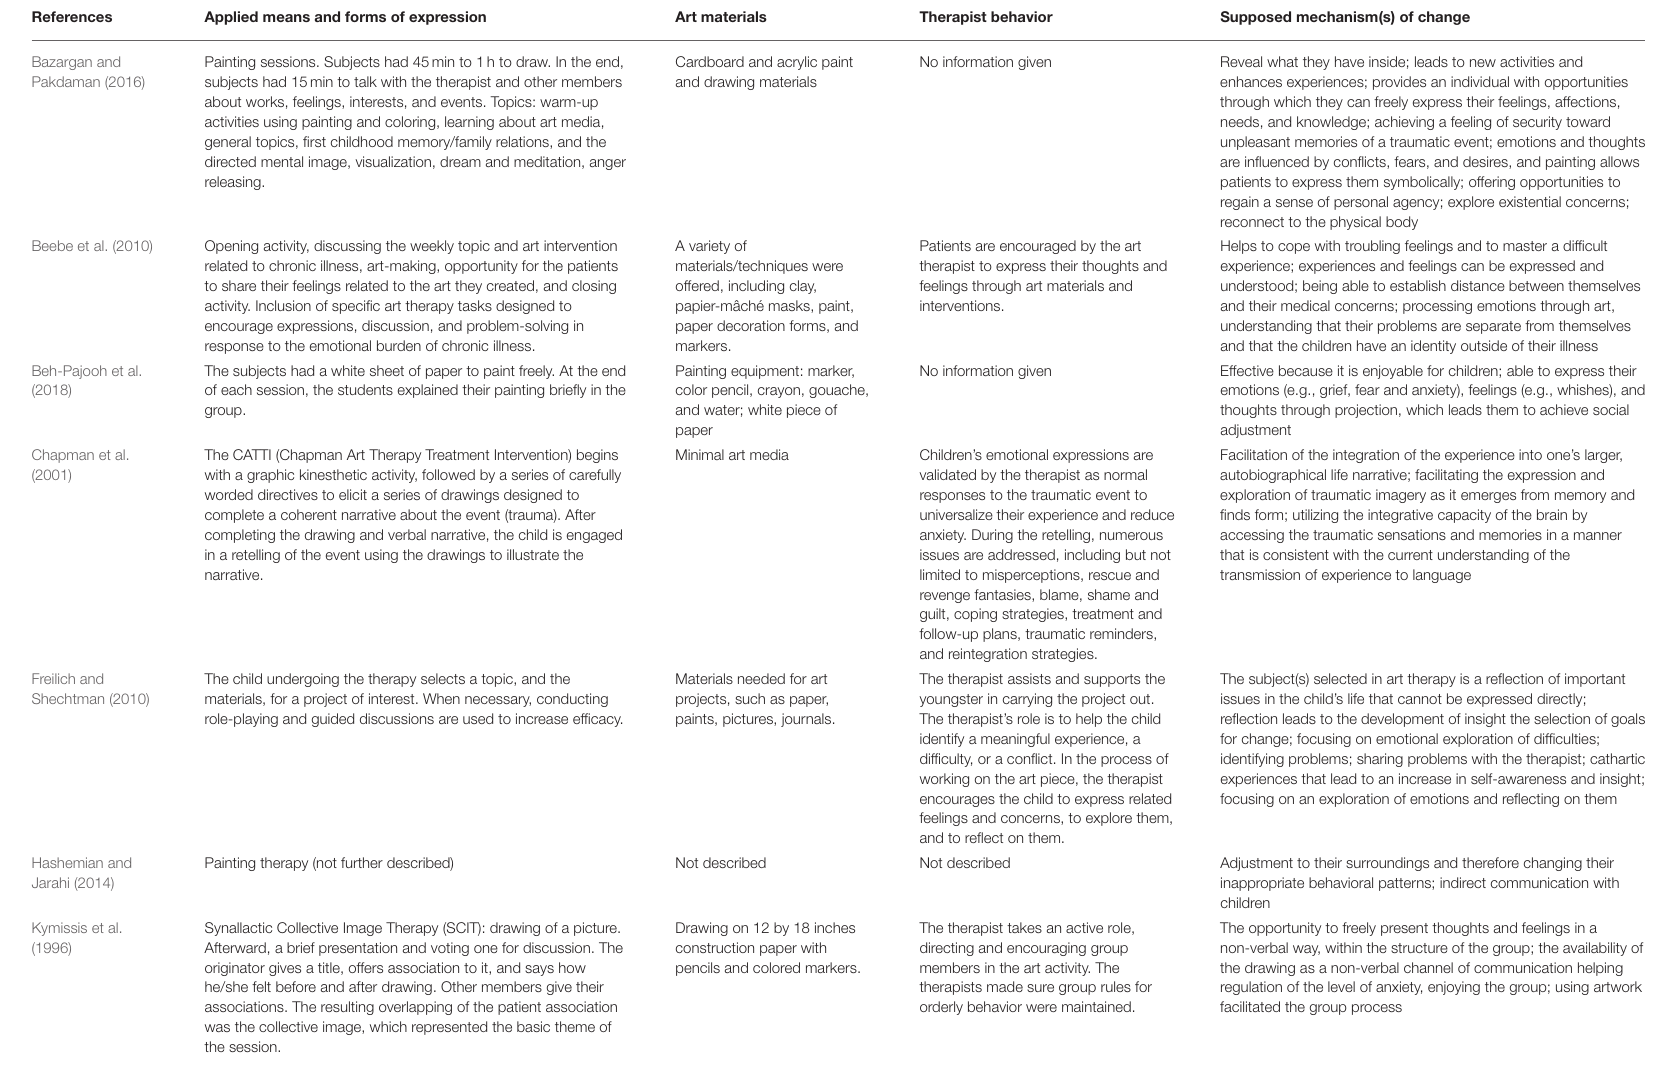
TABLE 2 | Characteristics AT